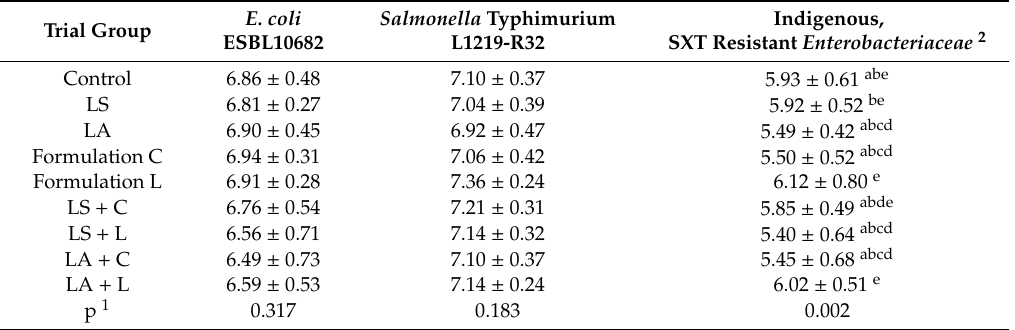
Table 3. Impact of direct-fed microbials (DFM) and phytobiotic feed additives on bacterial growth after 4 h incubation of inoculated cecal samples with the donor ( E. coli ESBL10682) and recipient ( Salmonella